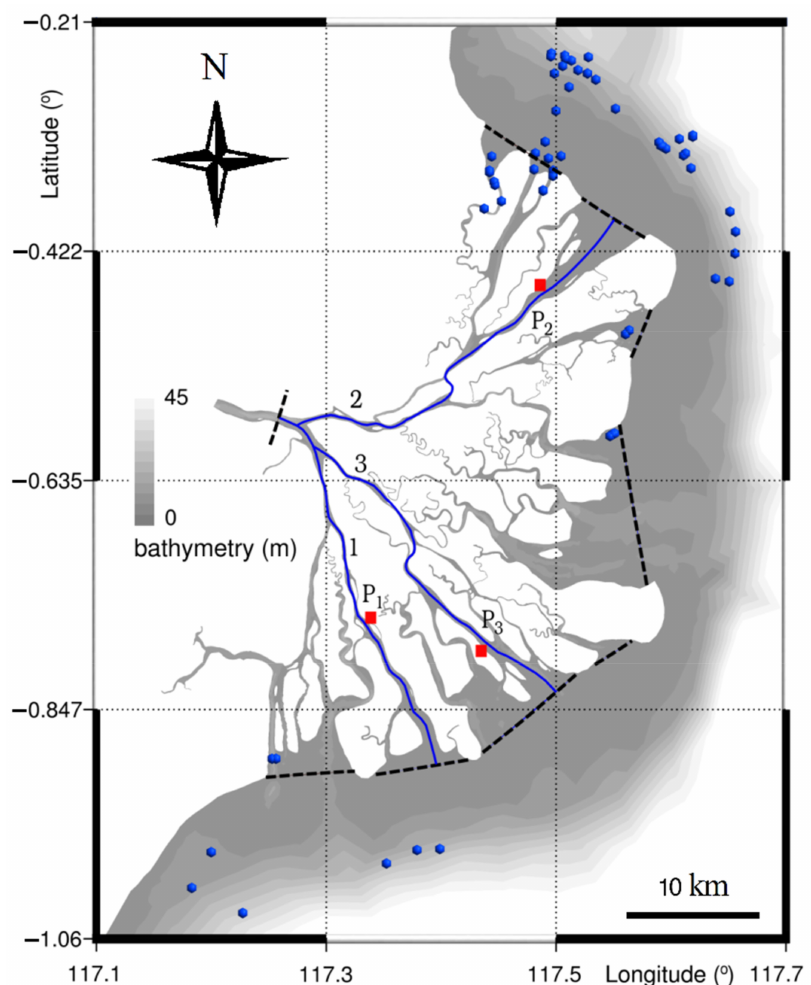
Figure 3. Bathymetry in the delta and the delta front, with field sampling sites of salinity (blue dots), upstream and downstream boundaries (black dashed lines) for computing the water renewal timescales, the three considered transects (blue lines) and three points (red